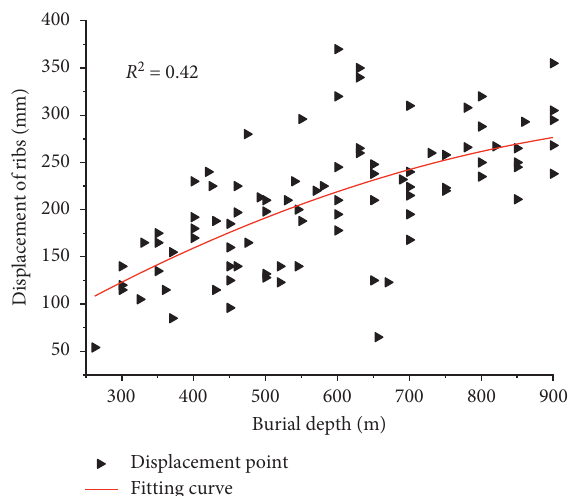
Figure 14: Displacement of ribs (50 th day).